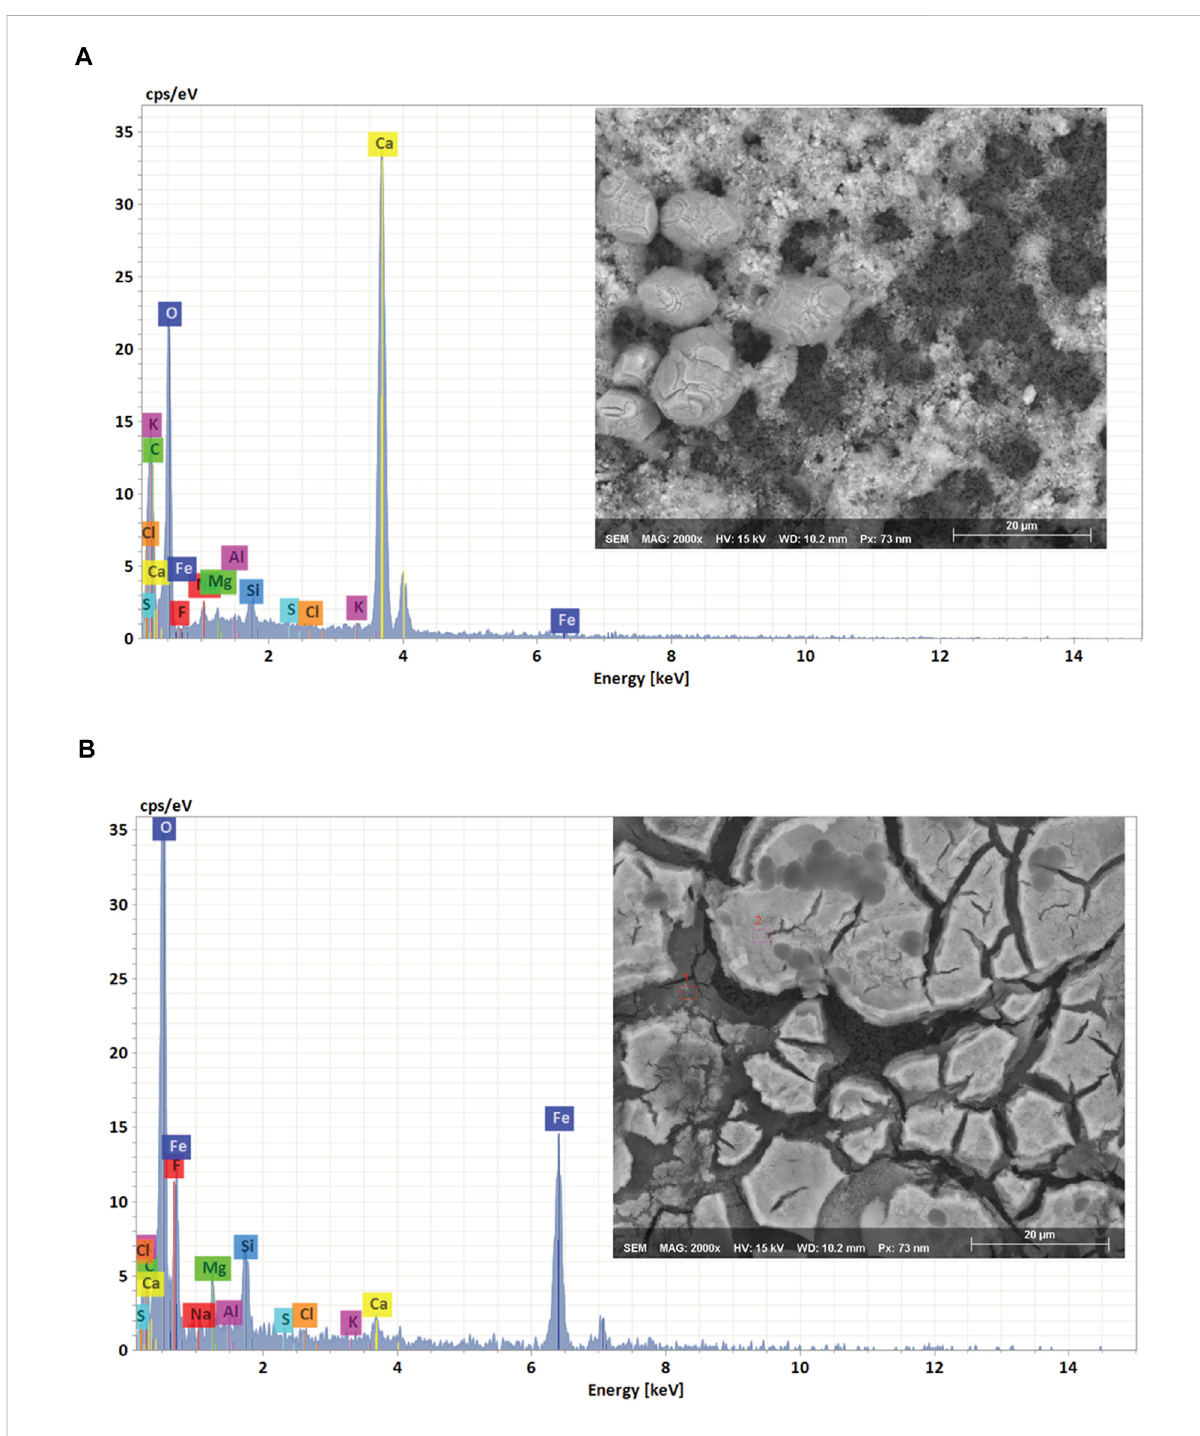
FIGURE 2 SEM image and EDS spectrum of the recovered precipitates (A) CaCO 3 and (B) Fe (OH) 3